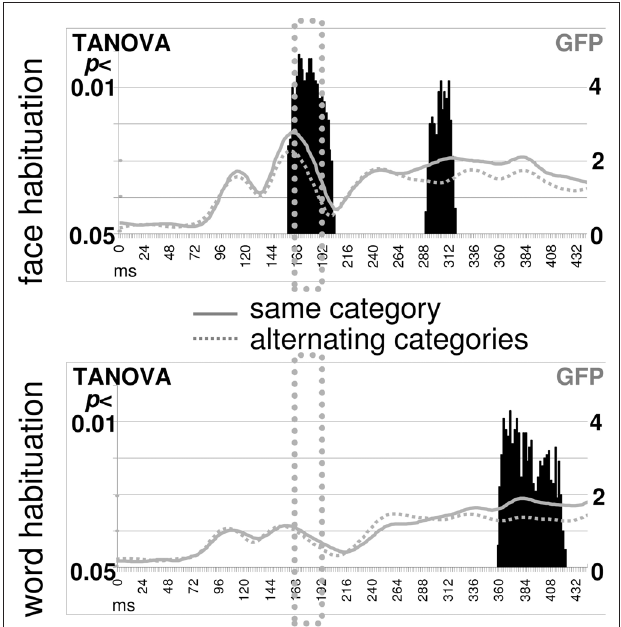
FIGURE 2 | Time point-wise habituation effects. A point-to-point comparison (TANOVA) between ERP maps from the same-category “blocked” condition and ERP maps from the “alternating” categories condition revealed effects of habituation ( p < 0.01) in the N170 time range for faces (top) but not for words (bottom). Overlaid are the GFP curves indicating that the N170 response was stronger for faces than words and that the habituation effect for faces started at the N170